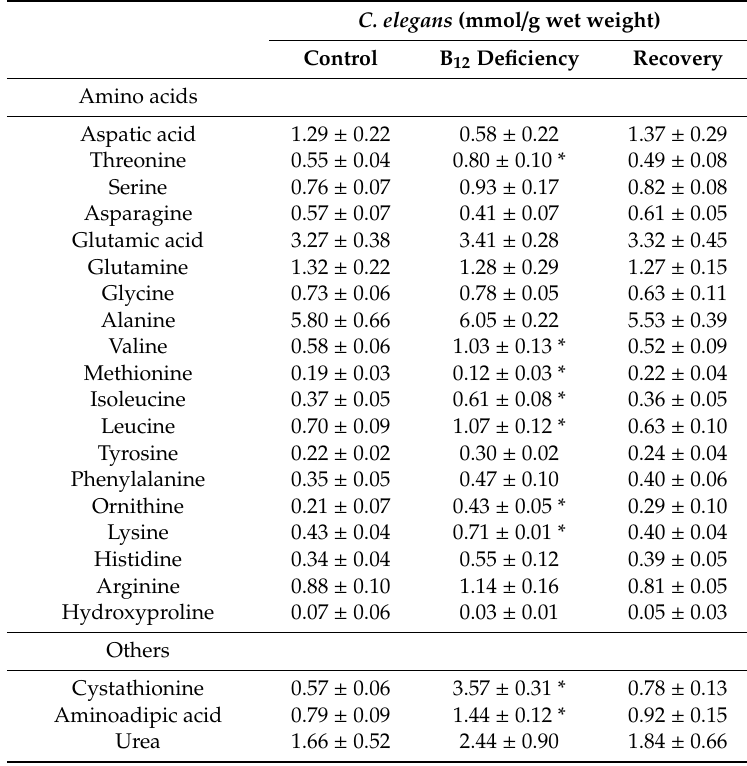
Table 1. Concentrations of free amino acids and other compounds in C. elegans